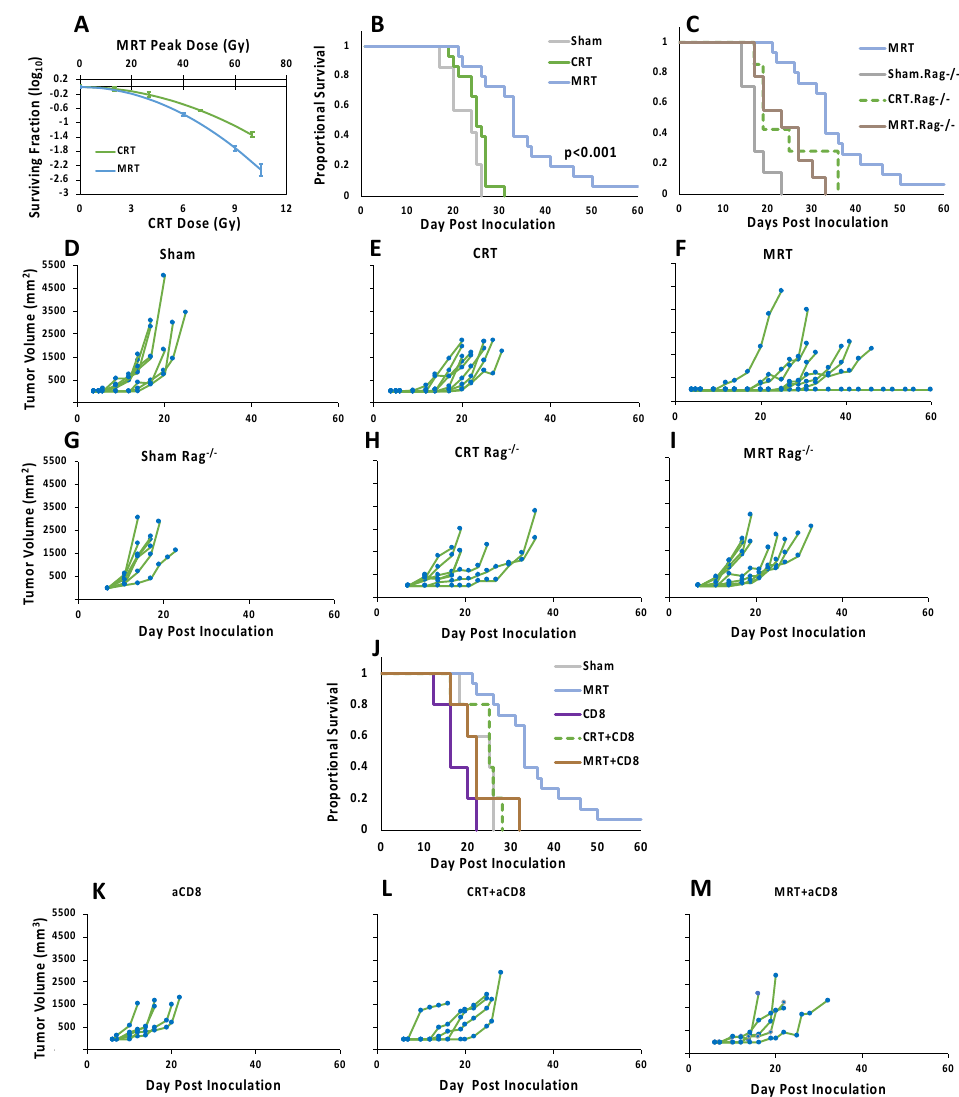
Figure 3. Treatment efficacy of various treatment modalities on immunocompetent and immunod- eficient mouse models. ( A ) Clonogenic assay utilized to evaluate the in vitro response of B16-F10 after different doses of radiation in the following two treatment modalities: CRT and MRT. ( B , C , J ) Kaplan–Meier curves demonstrate the fraction of mice that survived at different time-points after tumor cell inoculation, the p -values calculated by log-rank test and adjusted using FDR. ( D – I , K – M ) Tumor size at different time-points after tumor inoculation in the different treatment groups, in immunocompetent, Rag − / − and CD8-depleted mouse models. ( F ) One mouse in MRT group survived the primary challenge. MRT: microplanar radiotherapy; CRT: conventional radiotherapy; Rag − / − : model is homozygous for the Rag 1tm1Mom mutation, and lacks mature T and B cells; aCD8: injected with anti-CD8.